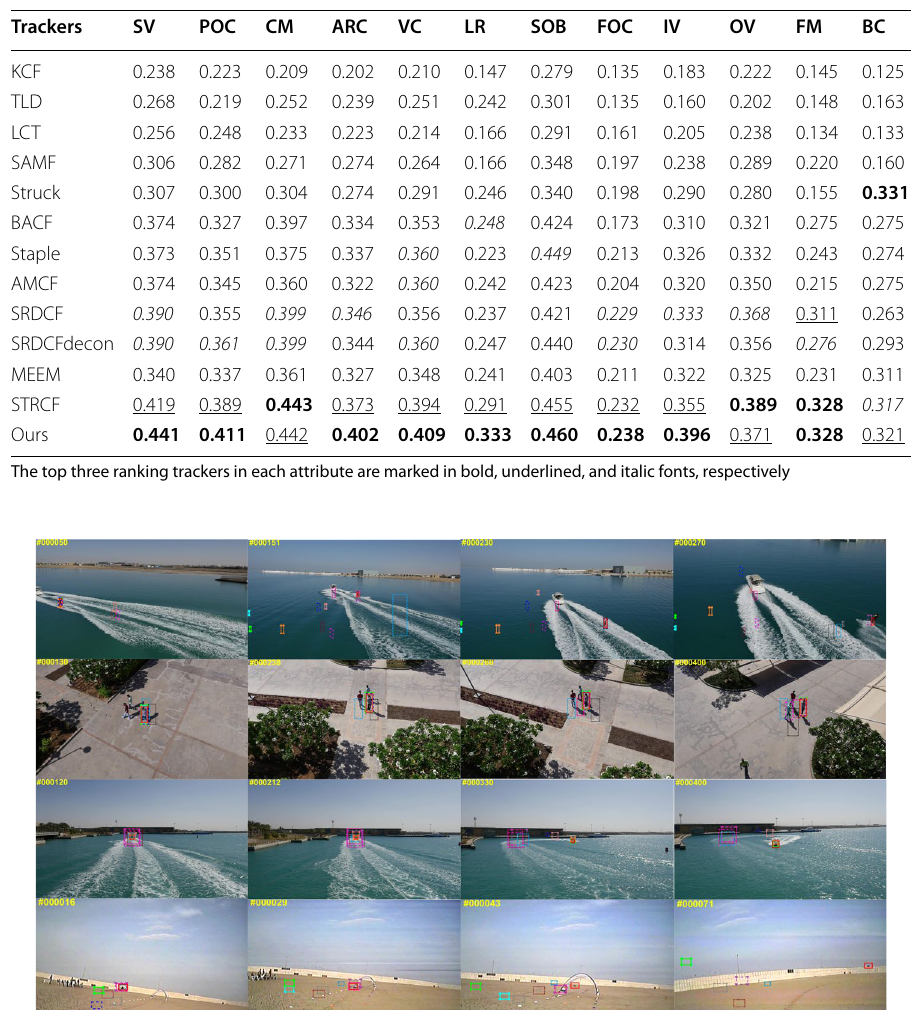
Table 2 Success scores (AUC) of the different attributes of all trackers on the UAV123@10fps dataset Trackers